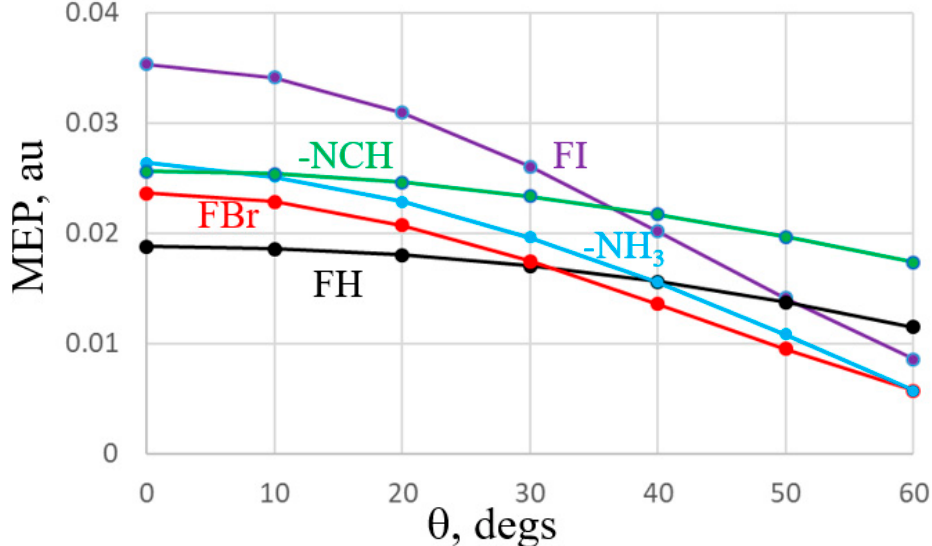
Figure 5. MEP of indicated molecule as function of θ defined as deviation from FX axis for acids, NCH axis for NCH, and C 3 symmetry axis of NH 3 . Potentials were evaluated along a circle centered about the X or N atom, with a radius of 3 Å. The negative of the potential is shown for NCH and NH 3 .